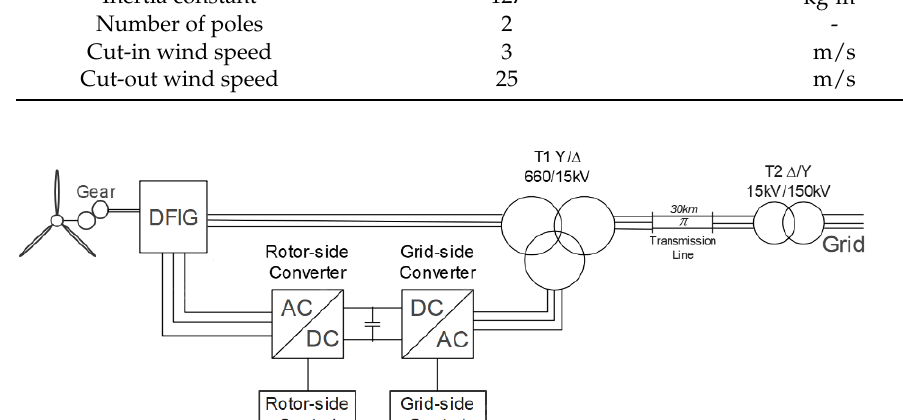
Figure 10. Proposed grid-connected DFIG-based WECS system. Table 1. DFIG parameters.